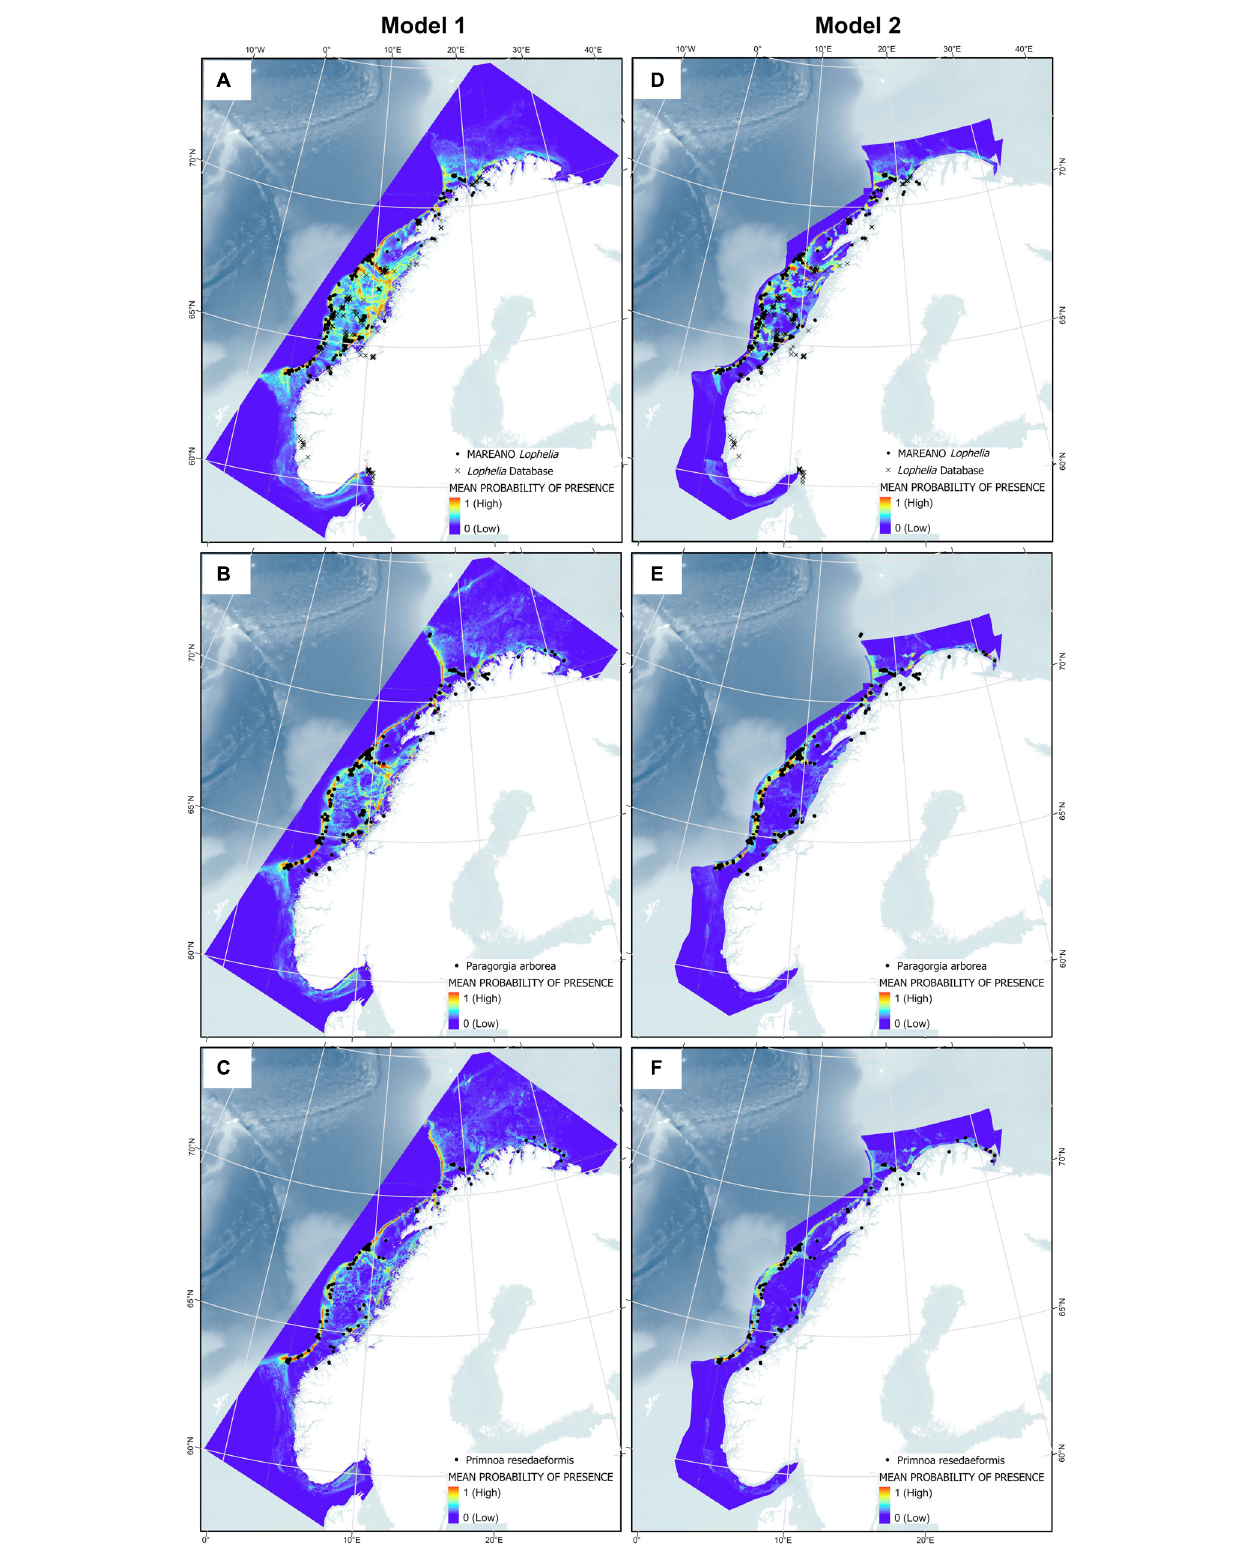
FIGURE 10 | Presence points of Lophelia pertusa (A,D) , Paragorgia arborea (B,E) , and Primnoa resedaeformis (C,F) on the Norwegian continental shelf overlaying the results from Model 1 and 2.